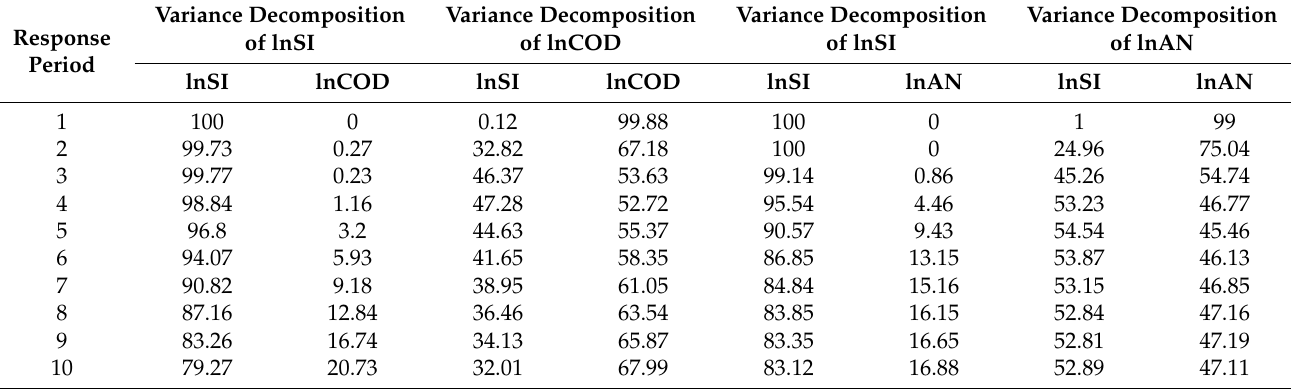
Figure 2. Impulse response relationship between industrial structure adjustment and the discharge of pollutants to the aquatic environment in Shaanxi, ( a ) Impulse response of lnCOD to lnSI, ( b ) Impulse response of lnAN to lnSI, ( c ) Impulse response of lnSI to lnCOD, ( d ) Impulse response of lnSI to lnAN. Table 4. Forecast variance decomposition of the discharge of pollutants to the aquatic environment in response to industrial structure adjustment in